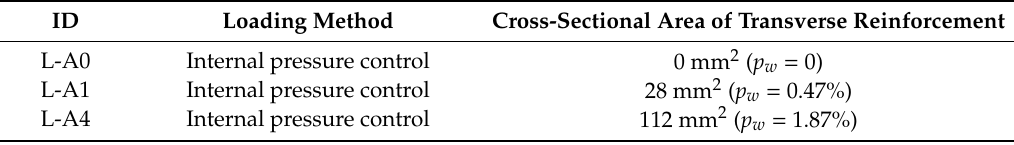
Figure 11. Stress–strain curve and mechanical properties of elements used in the numerical model: ( a ) concrete; ( b ) transverse reinforcement. Table 3. Details of specimens for numerical simulation.